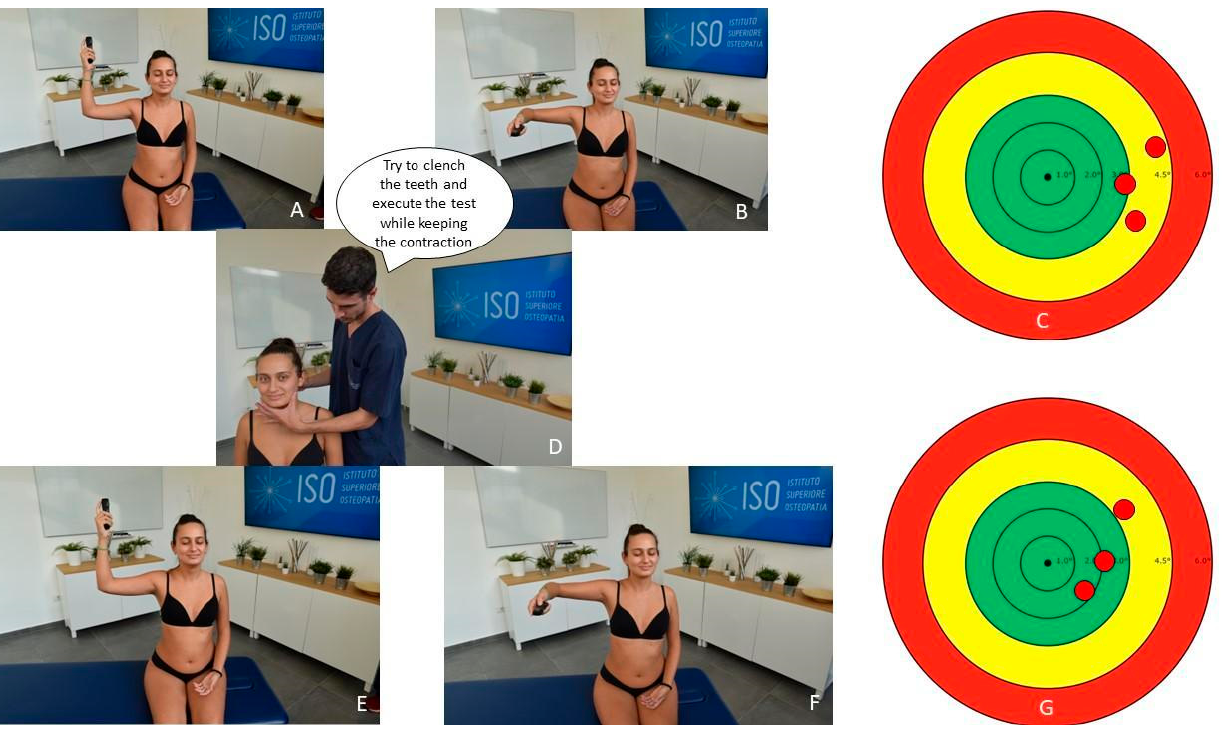
Figure A4. Clinical scenario 4. Clinical scenario n. 5 (Figure